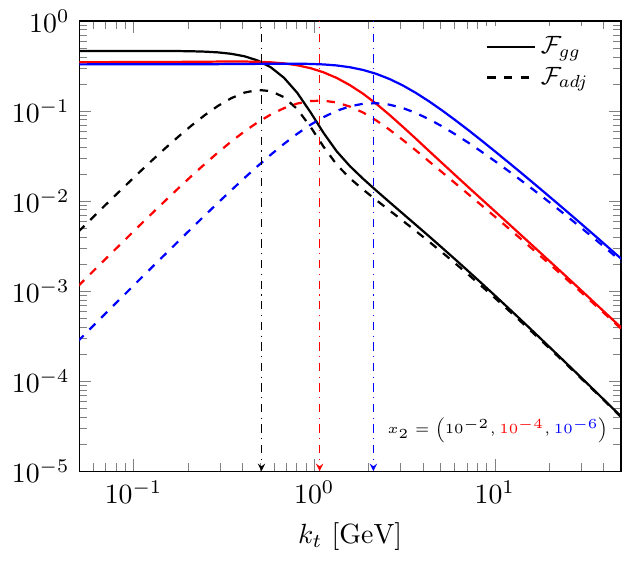
Figure 3 . Gluon TMDs F gg (solid lines) and F adj (dashed lines) as a function of transverse momentum k t = | k t | with fixed x = 10 − 2 (black), 10 − 4 (red) and 10 − 6 (blue). The pre-factor α s /S ⊥ is omitted. The saturation scale Q s ( x ) is defined here as the peak position of F adj , indicated by a dash-dotted arrow for each x